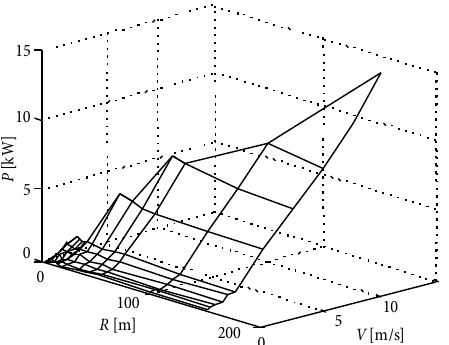
Fig. 13. Chart of simulation map of additional power loss (based on the values in Table 1)